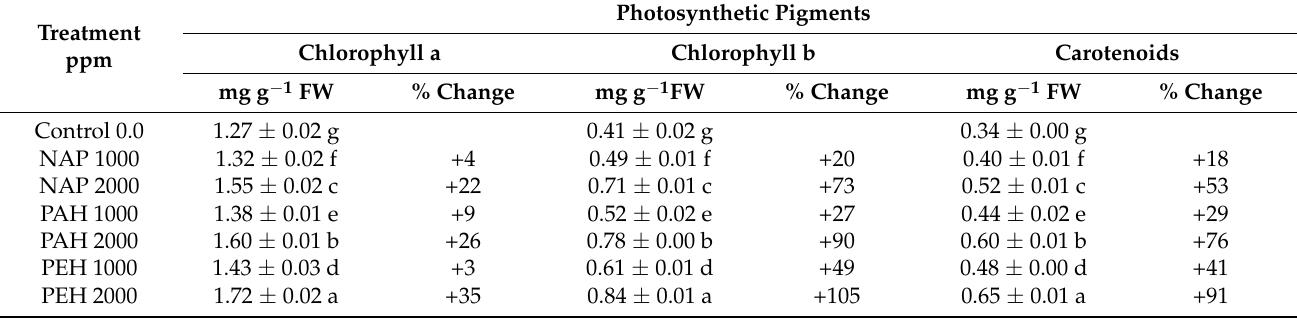
Table 4. Photosynthetic pigment contents in Pisum sativum leaves after foliar spray with native milk whey protein (NAP), papain-hydrolyzed whey protein (PAH) or pepsin-hydrolyzed whey protein (PEH) at two different concentrations; 1000 and 2000 mg L − 1 , as compared to normal control